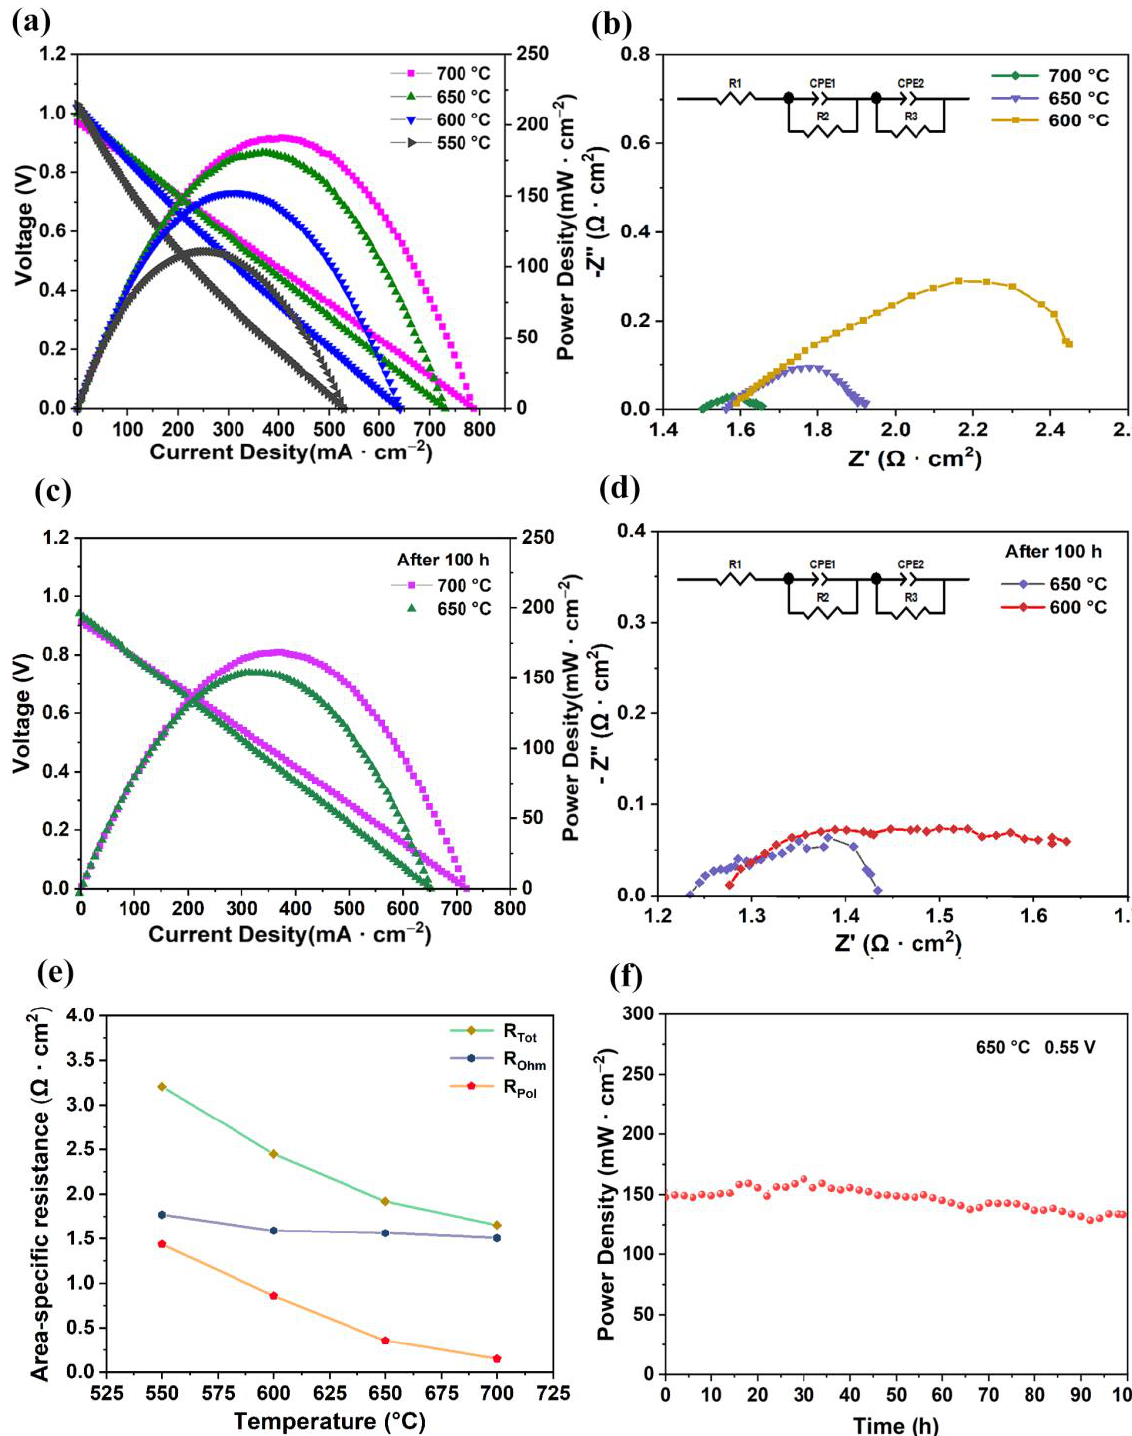
Figure 3. Electrochemical performance of SOFC mode with LSCF air electrode. ( a ) V-I and P-I test curves. ( b ) EIS spectra of cell at 700 – 600 °C. ( c , d ) V-I, P-I, and EIS test curves of fuel cell after 100 h stability test. ( e ) Area-specific resistances derived from Nyquist plots, total cell resistance (R Tot ), ohmic resistance (R Ohm ), and interfacial polarization resistance (R Pol ). ( f ) Stability test at a voltage of 0.55 V at 650 °C for 100 h.